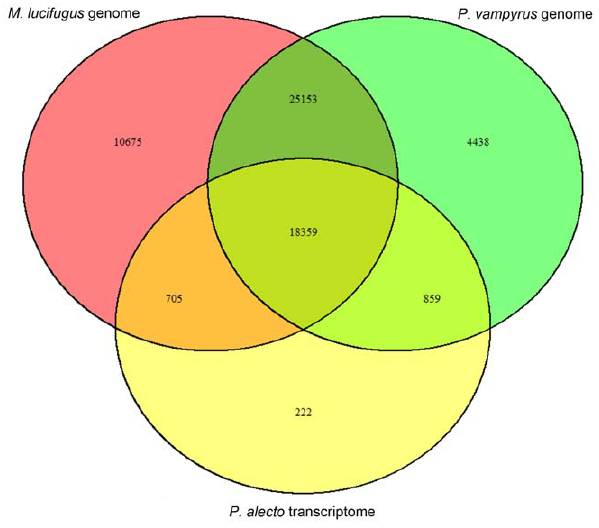
Figure 5. Venn Diagram comparison of unannotated transcript mapped to Myotis lucifugus genome, Pteropus vampyrus ge- nome, and Pteropusalecto transcriptome.